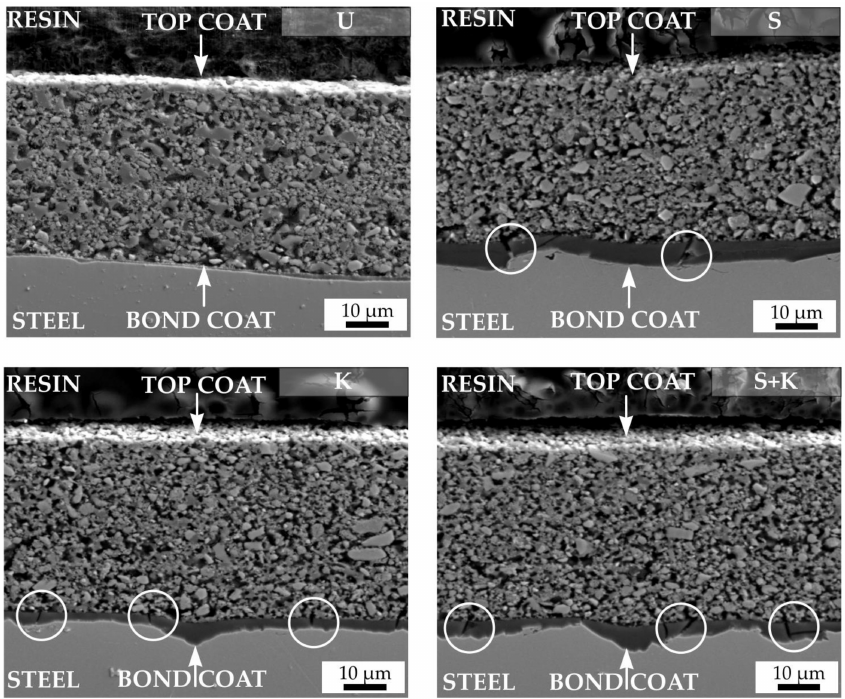
Figure 8. SEM cross sections of pyrolysed C2c coatings. The applied cleaning procedure is indicated by the abbreviation in the upper right corner of each figure (U – ultrasonic cleaning, K – chemical etching with Kroll’s reagent, S – sandblasting, S + K – sandblasting + chemical etching with Kroll’s